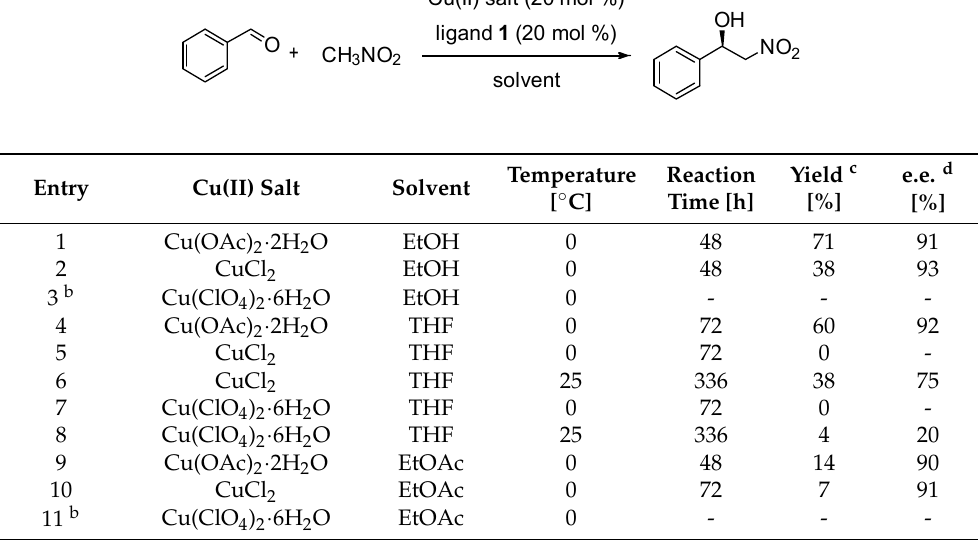
Table 2. Effect of counteranion and solvent on the reaction of benzaldehyde with nitromethane catalyzed by the 1:1 ligand 1 : Cu(II) complex a .